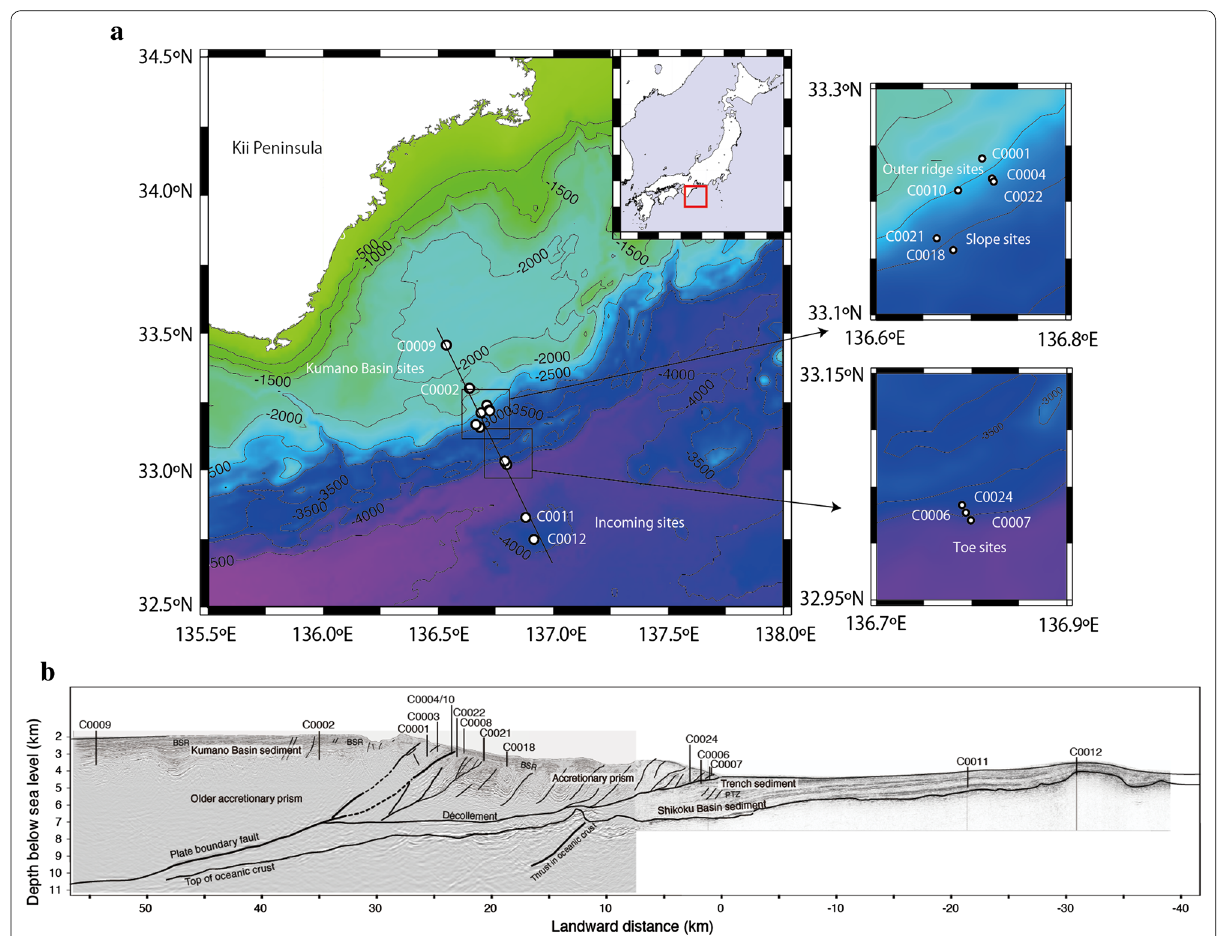
Fig. 1 Regional map of the Kumano transect in the Nankai Trough. a Map view of drilled sites in NanTroSEIZE project. Background color and contours show the bathymetry. White dots are the NanTroSEIZE drilling sites. A seismic line shown in b is presented by a black line. b Seismic profile along the Kumano transect after Figure F2A of Tobin et al.